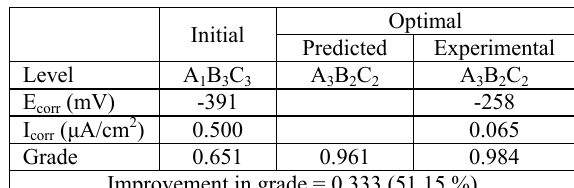
Table 6. Results of the validation test